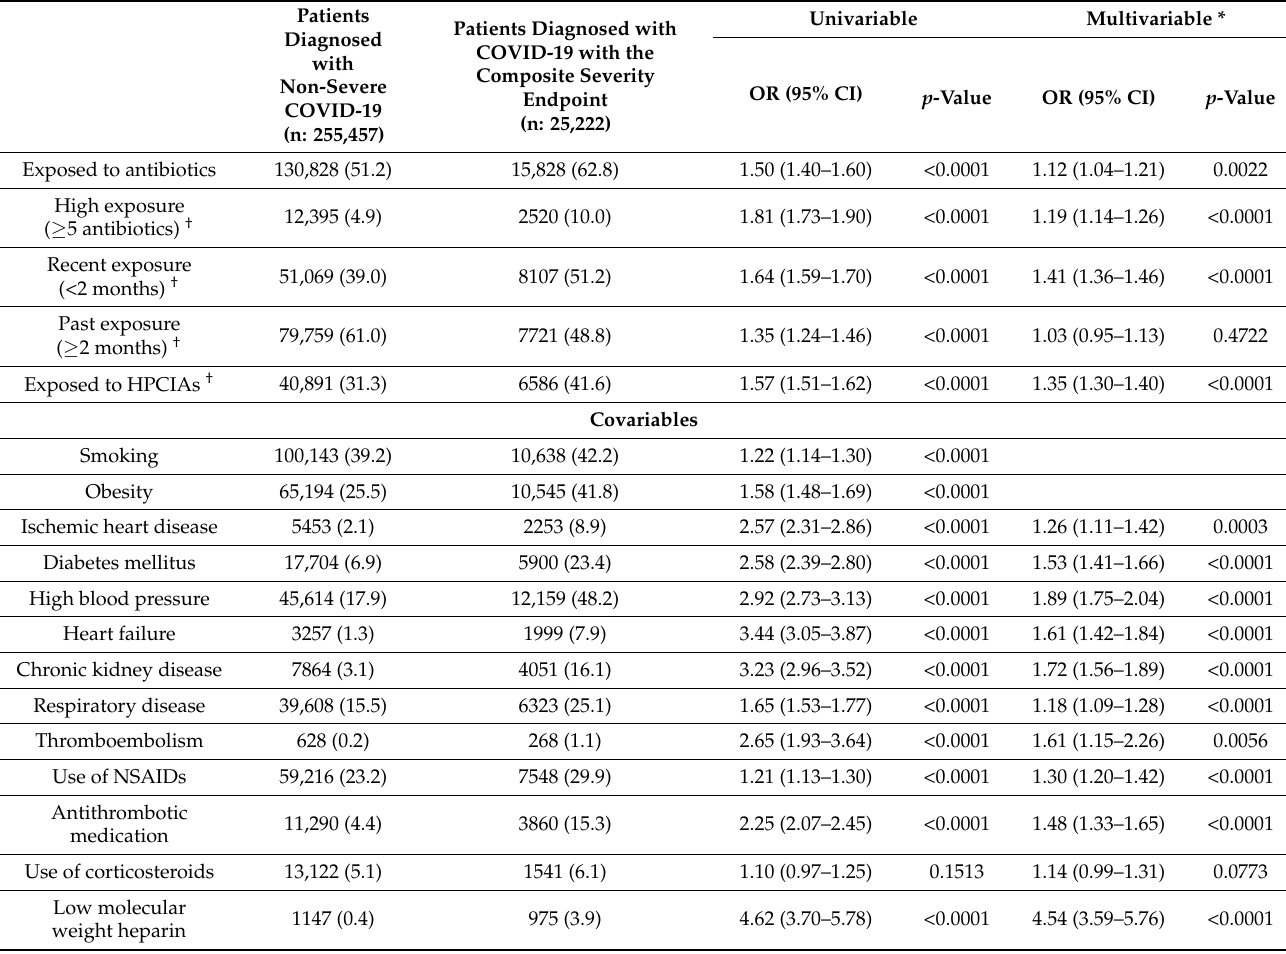
Table 2. Marginal structural model of the adjusted association between exposure to antibiotics among patients with COVID-19 infection and the composite severity endpoint, combining death, hospitalization and/or pneumonia related to COVID-19.